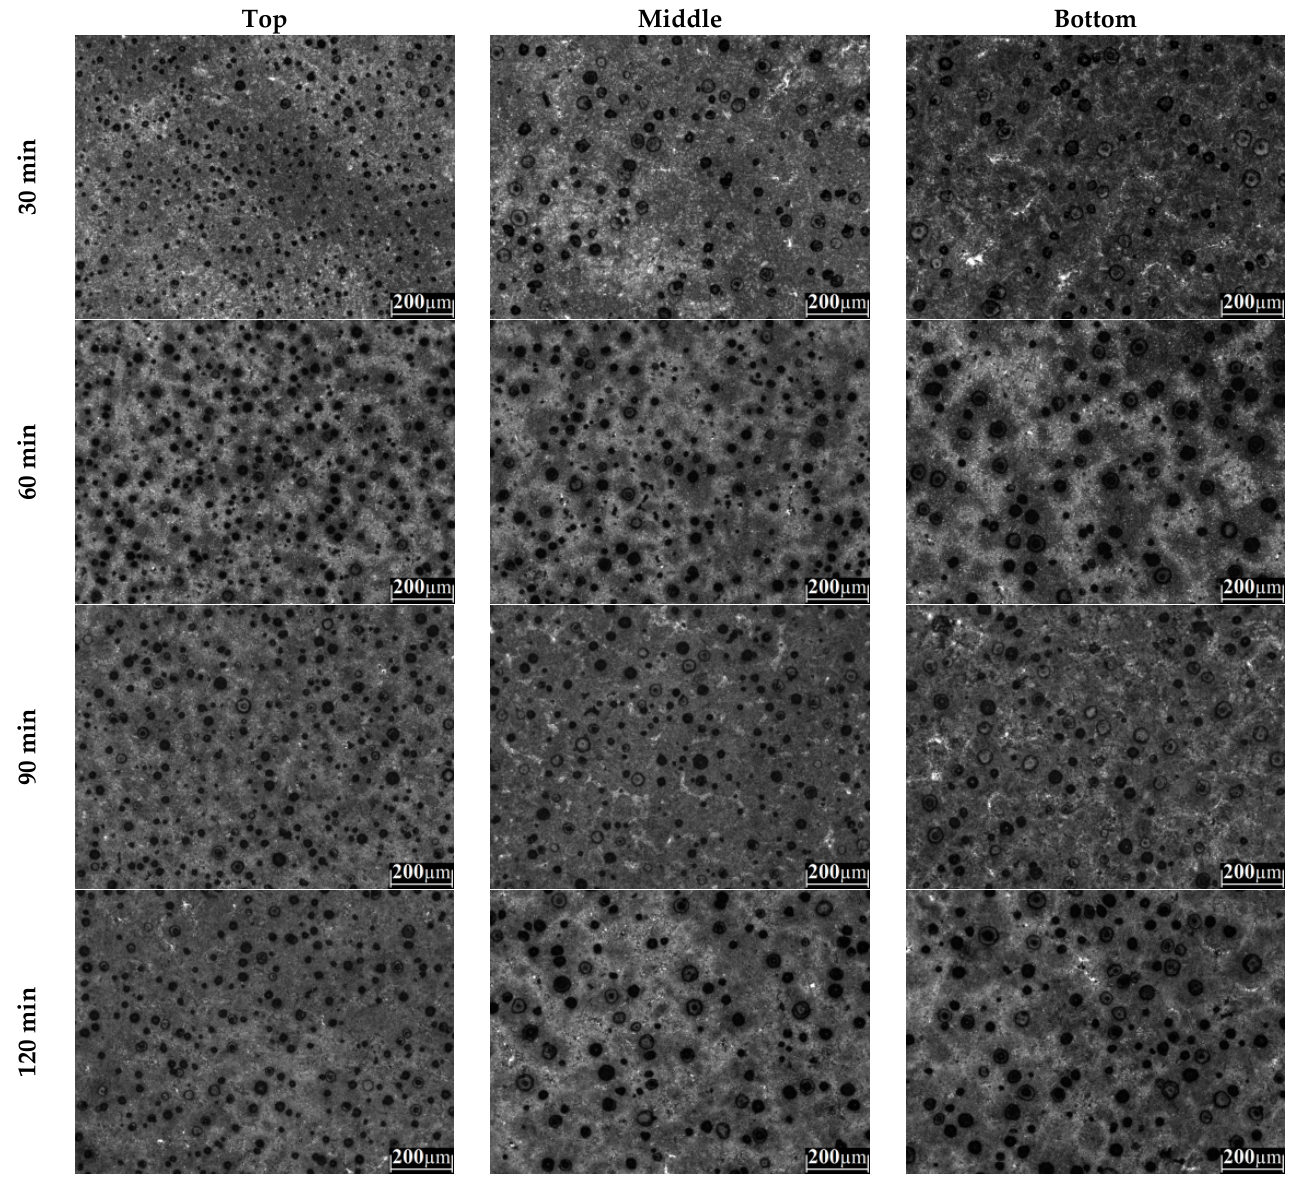
Figure 5. Microstructural evolution for the ADI-0.2V-265 sample at the austempering times of 30, 60, 90, and 120